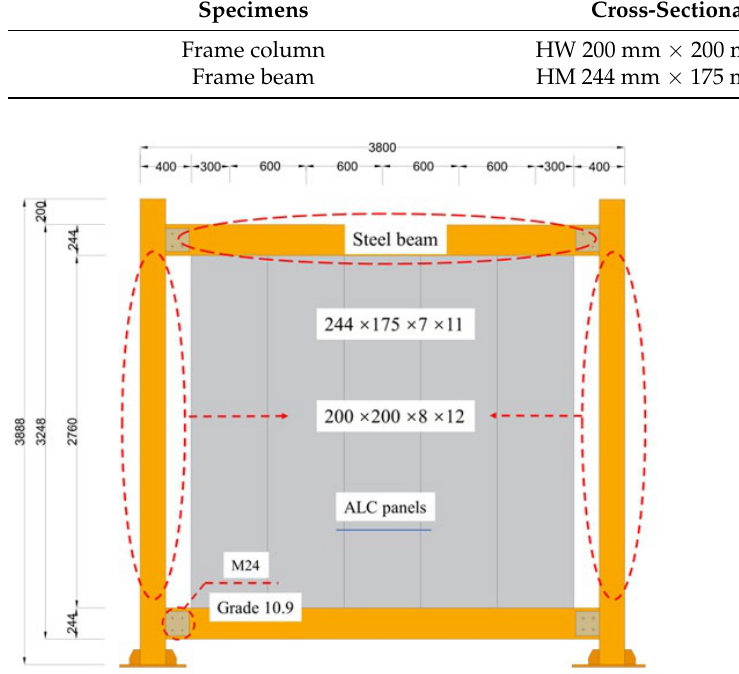
Figure 3. Detail of connectors. ( a ) L-hooked bolt. ( b ) Upper node. ( c ) Lower node.